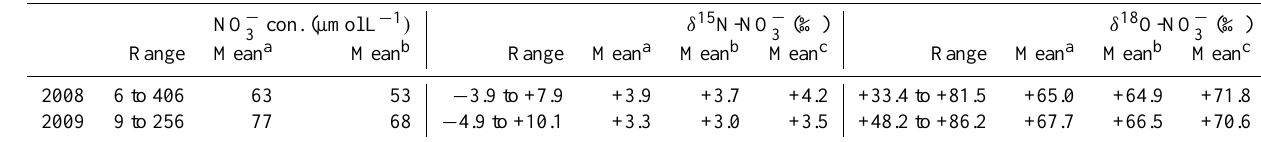
in precipitation. 3